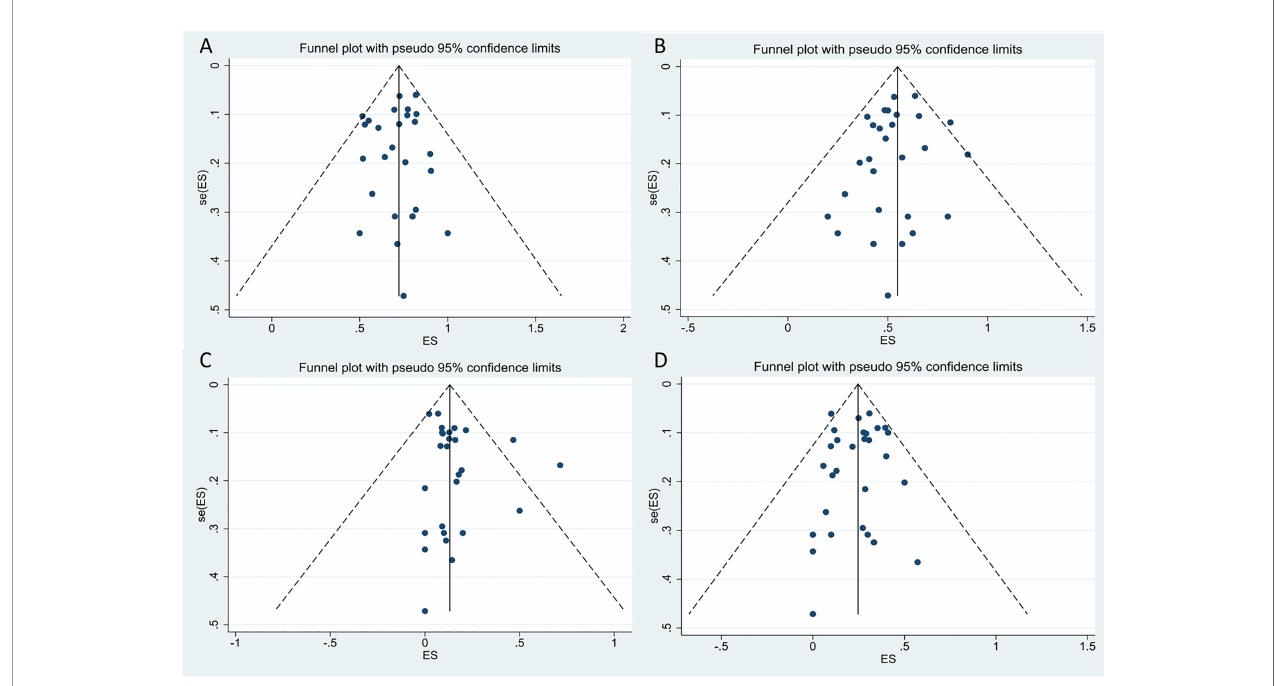
FIGURE 9 | The funnel plots for included studies. (A) The funnel plot of total overall response rate. (B) The funnel plot of total complete response rate. (C) The funnel plot of total cytokine release syndrome rate. (D) The funnel plot of total immune effector cell-associated neurotoxicity syndrome rate.